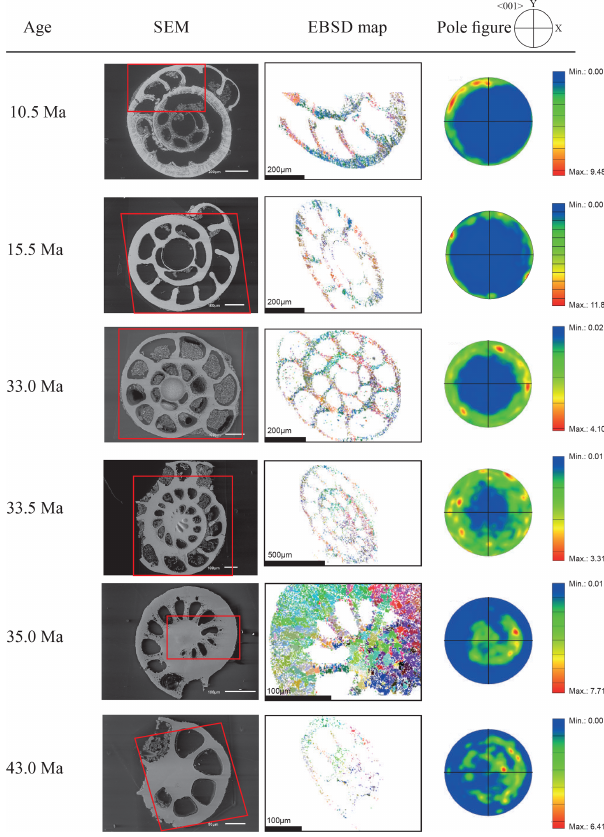
Figure 3. EBSD analysis of Gyroidinoides soldanii tests from the Pacific equatorial region. Left: SEM images of the analysed specimens. Middle: EBSD maps displaying crystal orientations in colour-coded Euler angles. Right: pole plot figures showing cluster density of the c axes in contouring pole figures, half-width: 10 ◦ , Cluster size: 5 ◦ . The c axes show a relatively strong dispersion within the pole figures and no apparent crystallographic preference. The distribution is indicating a broad clustering and patches with similarly oriented crystals. No apparent change in the size of the clusters with increasing age is observed.